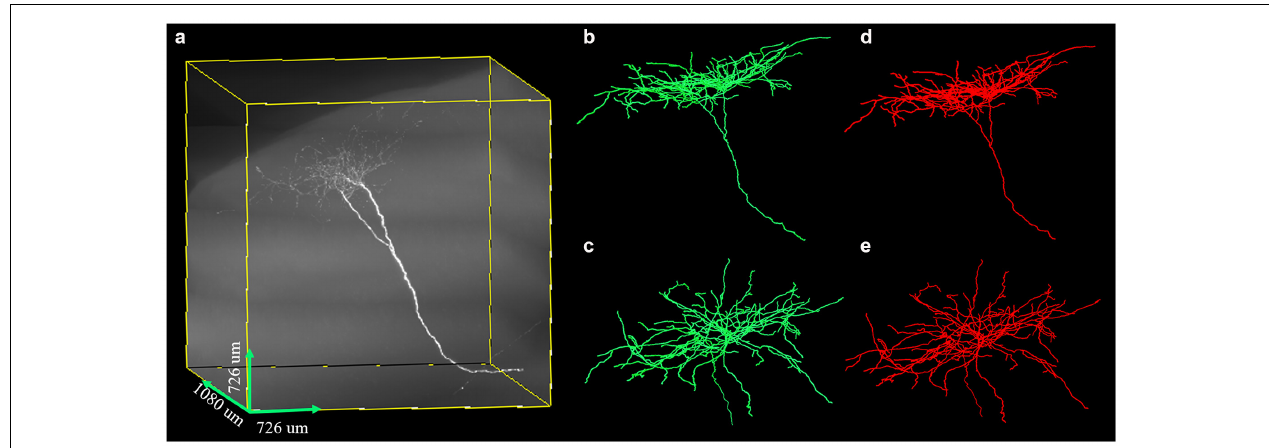
FIGURE 10 | Performances of the proposed method on large-scale neuron data (A) with uneven signal and highly branched axons. Panels (B–E) are the traced result (green, B,C ) by the proposed method and gold standard (red, D,E ) in different 3D